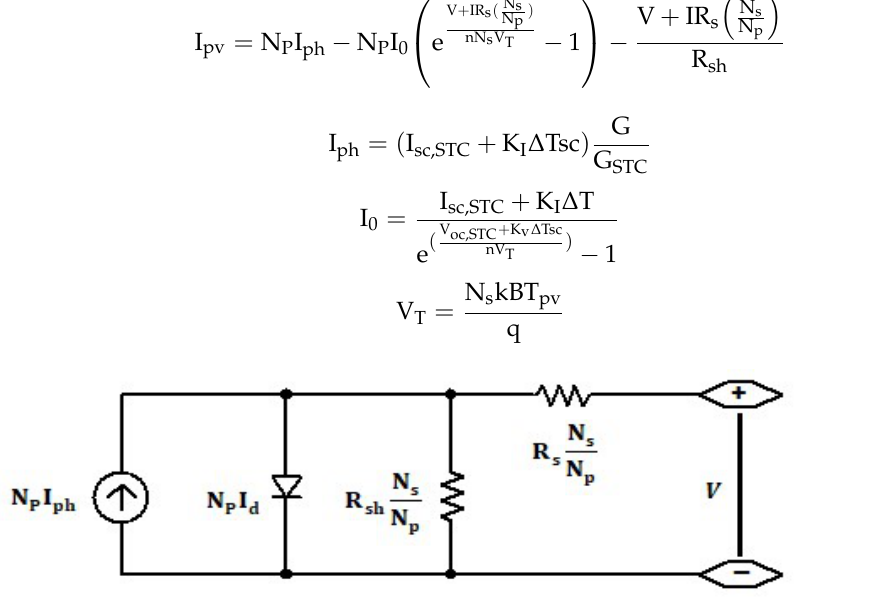
Figure 2. Photovoltaic electric module.